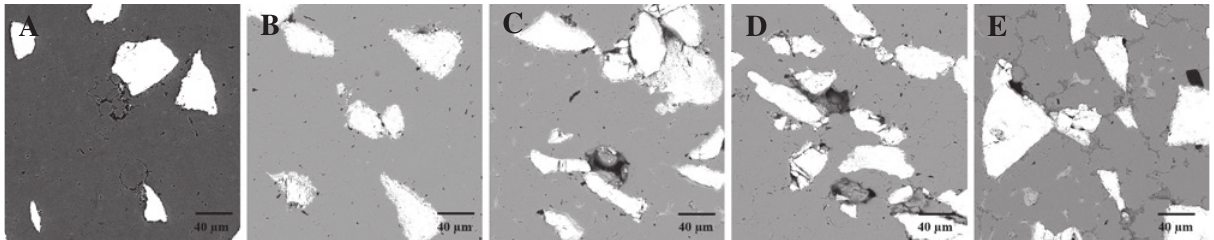
Figure 8: SEM micrographs of the internal microstructure of the composite Cu-WC with different volume fractions of reinforcing particles: